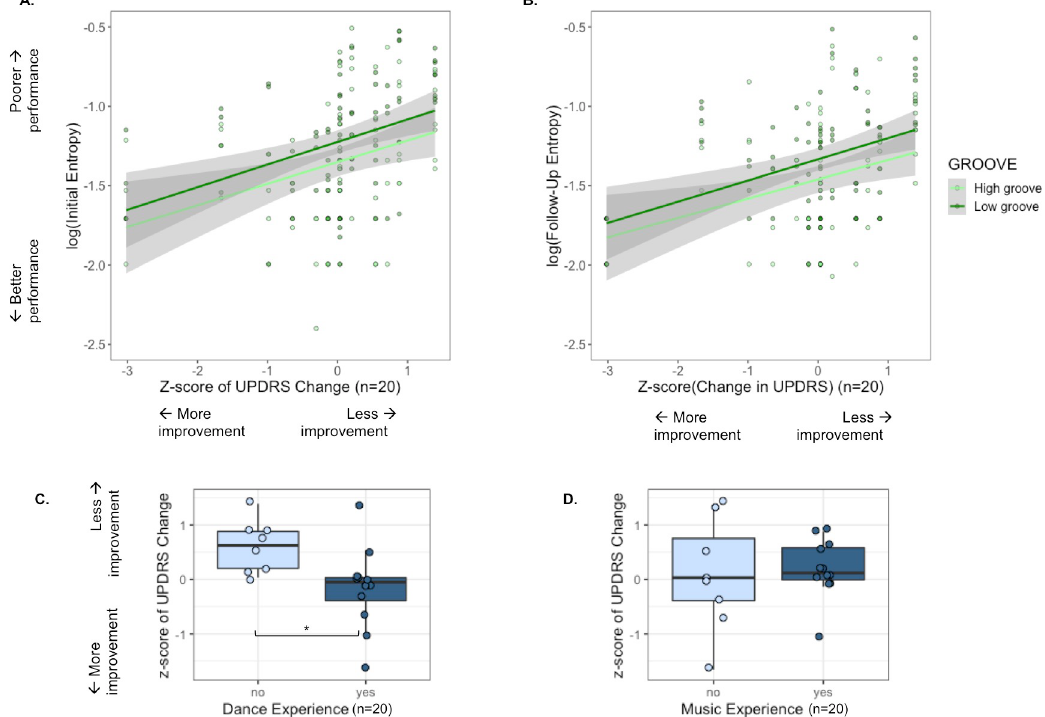
Fig 6. A. Relationships between entropy of pre-intervention tapping data and z-scores of changes in UPDRS from baseline to four months, for high-groove and low-groove trials. B. Relationships between entropy of post-intervention tapping data and z-scores of changes in UPDRS from baseline to four months, for high-groove and low-groove trials. C. Z-scores of changes in UPDRS from baseline to four months for participants with and without dance experience. D. Z-scores of changes in UPDRS from baseline to four months for participants with and without music